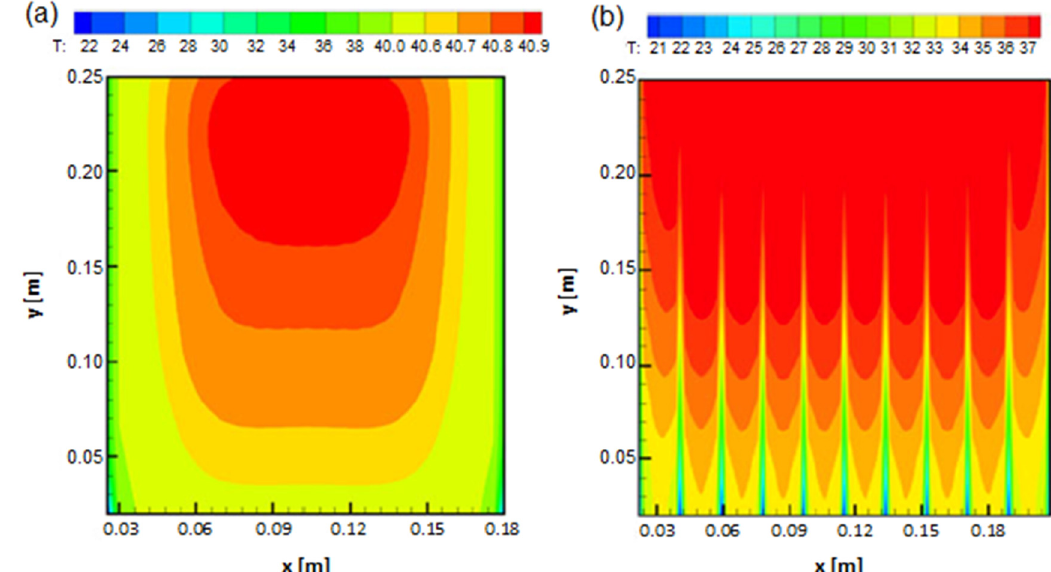
Figure 3. Simulated temperature distribution results indicating the effectiveness of the optimised thermal management system; ( a ) Base model; ( b ) Optimised model